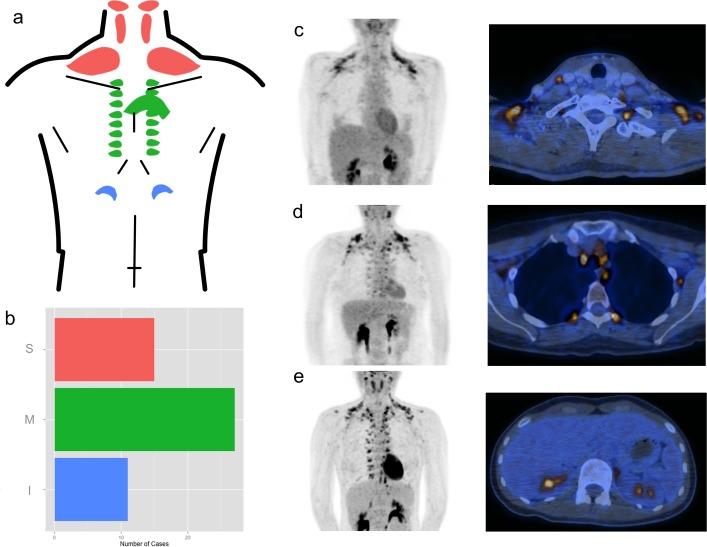
Morphologic Patterns of BAT.a) Schematic drawing of the different depots, some of which were summarized as indicated by the coloration into the three categories c) supraclavicular d) mediastinal and e) infradiaphragmatic. b) Showing the total number of BAT-positive subjects grouped by the most caudally active depot of either supraclavicular (including axillary and nuchal), mediastinal or infadiaphragmal BAT. c-e) Coronal MIP PET images (left) and fused PET/CT slices (right) of representative subjects in the according category. All pictures also show variable glucose uptake of the liver, intestines and myocardium as well as strong emissions from the renal pelvis, the latter being concentrated 18FDG breakdown products excreted through the urine. This can be appreciated in the fused d) image, where the true BAT activity is located in a fat depot on the patient’s left side (right side on the picture) adjacent to the first lumbar vertebra.